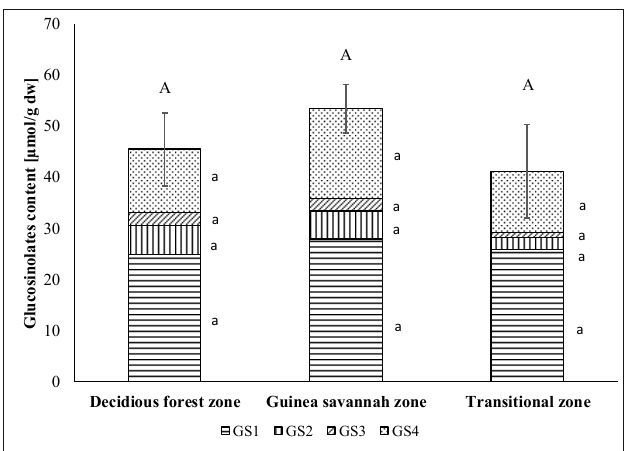
Fig. 2: Glucosinolates (GS) profile of leaves from wild Moringa oleifera plants in three agro-ecological zones. One-way ANOVA followed by Tukey's test, p ≤ 0.05. 4-α-rhamnopyranosyloxy-benzyl GS (GS1), three isomers of acetyl-4-α-rhamnopyranosyloxy-benzyl GS (GS2, GS3, GS4). Same lowercase letters indicate no significant differences for means of single GS among agro-ecological zones; same uppercase letters indicate no significant differences for means of total GS content (comprising of GS1-GS4). Error bars indicate standard deviations of mean total GS content.